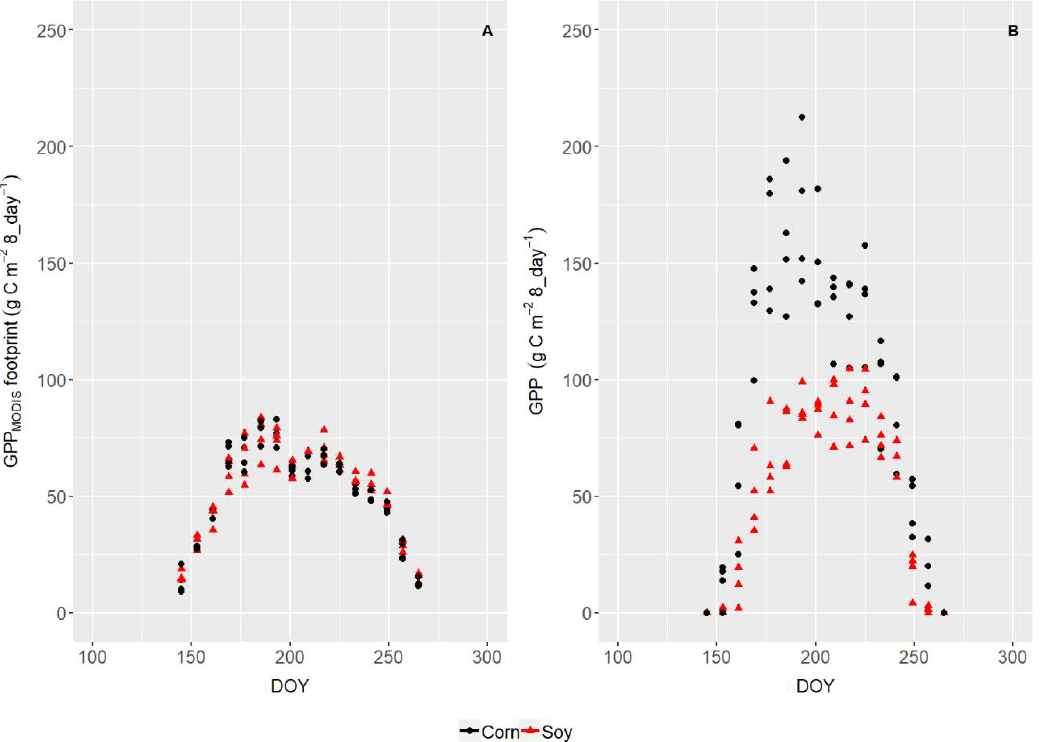
Figure A2. The gross primary production (GPP) averaged for corn (black circles, n=4) and soybean (red triangles, n=4) in four counties in North Central Iowa during the 2016 growing season (DOY 145 – 269); (A) The 8-day GPP MODIS product (g C m -2 8-day -1 ) within the 90% footprint area of the EC